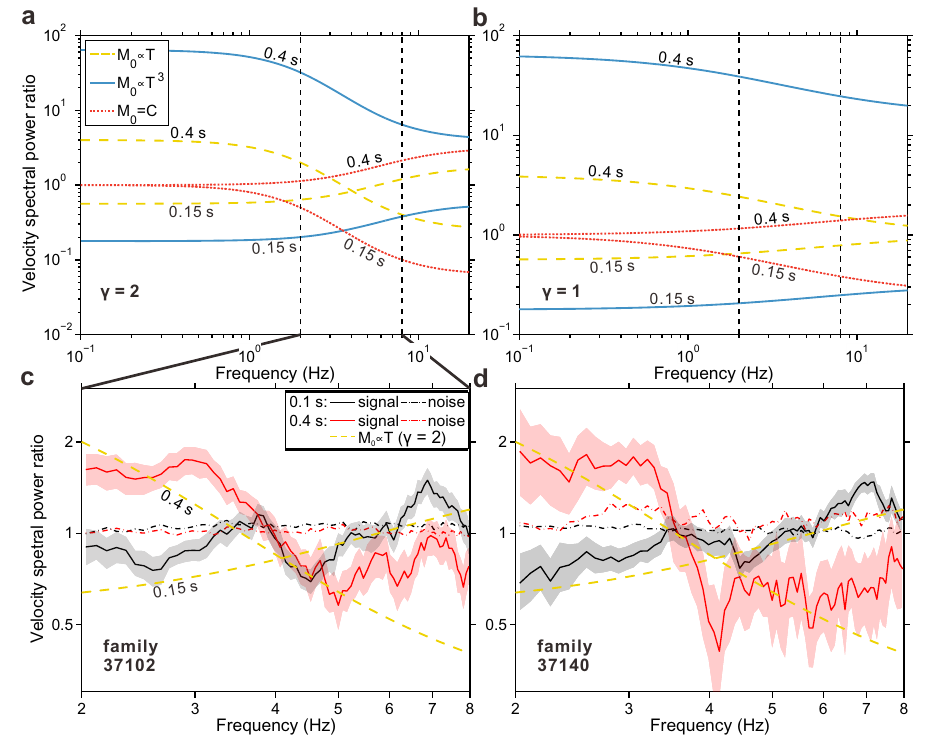
Fig.5|Evidenceforlinearmoment-durationscalingfromspectralobservations of low frequency earthquakes. a , b show the theoretical velocity spectral power ratios for different moment-duration scalings, assuming a high-frequency spectral fall-offrate γ of2and1,respectively(seeMethods). M 0 = C meansthatthemoment isconstant,independentofduration. c , d Blackandredsolidlinesshowthemedian noise-correctedspectralpower(componentE)observedatthetimesof0.1-secand 0.4-secdetections,asnormalizedbythemedianpowerobservedattimesof0.2-sec